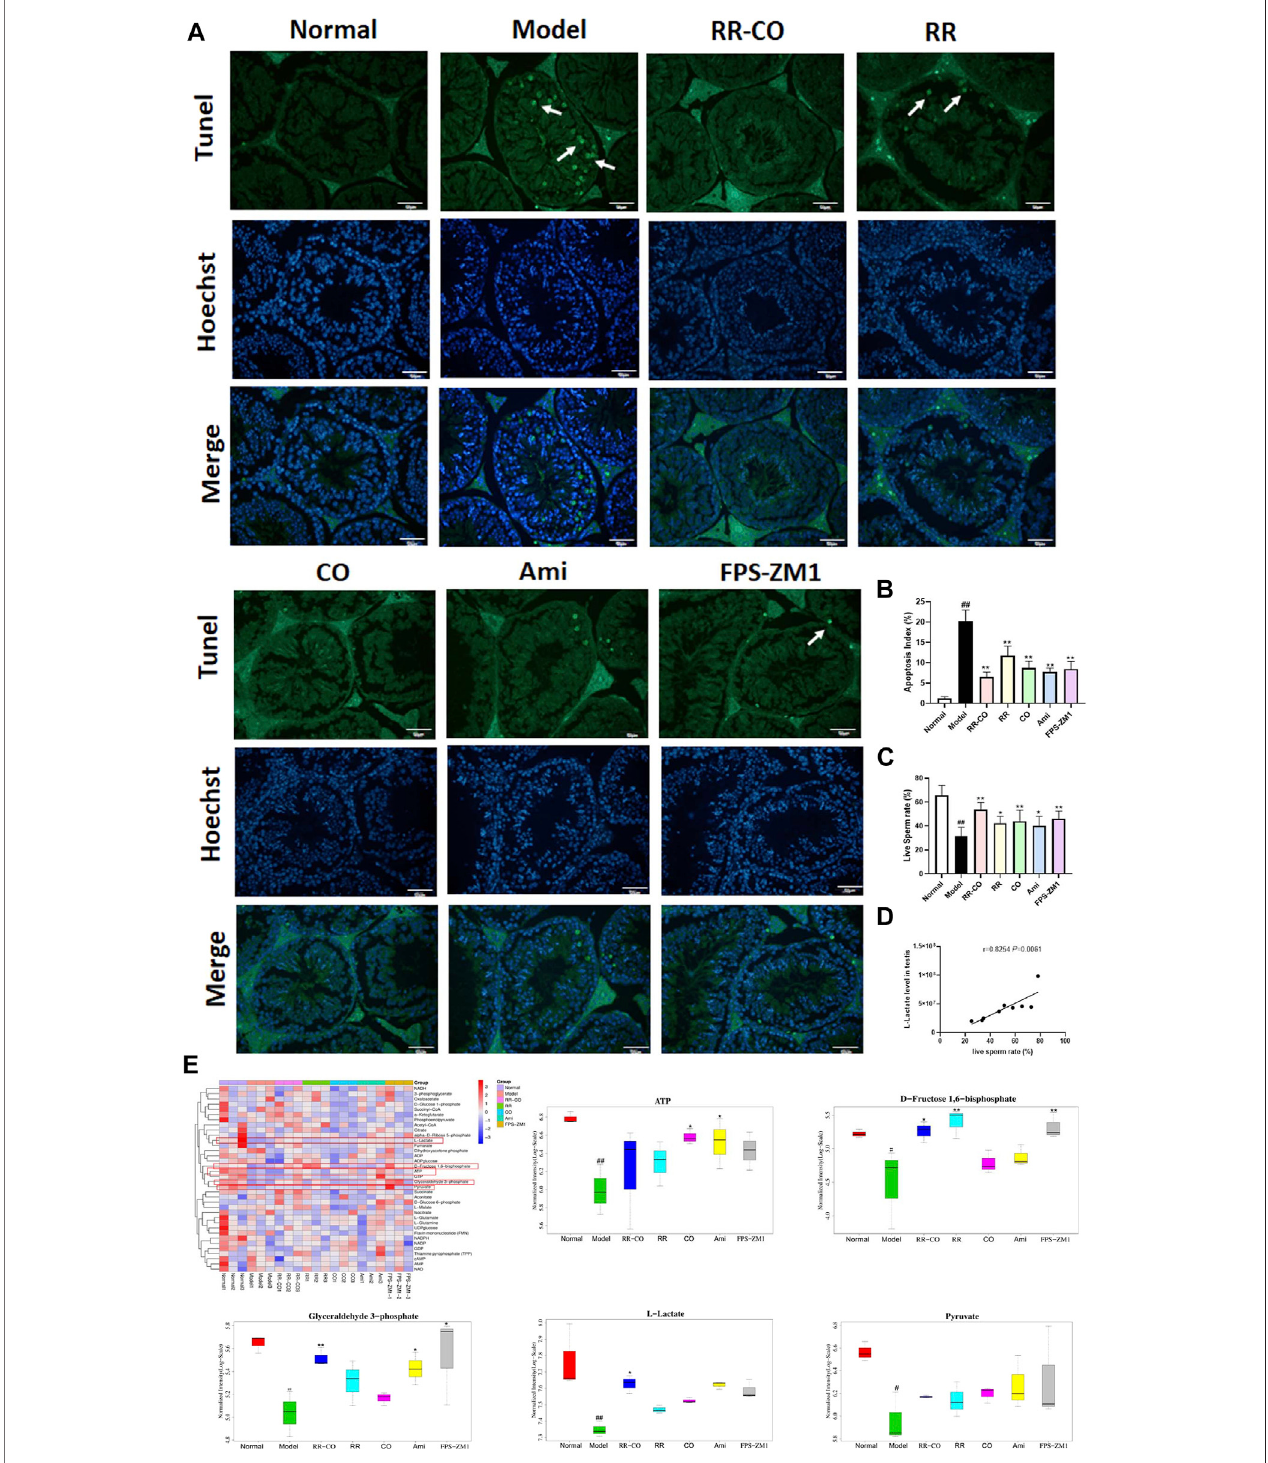
FIGURE3| EffectsofRR-COonthetestisapoptosis,glycolysismetabolites,andspermmotility (A) TUNELassaywasusedtodetecttesticularapoptosis,ofwhich apoptoticcellswereindicatedusingwhitearrows,and thecellnucleiweresubjectedtoHoechststaining(200 × magni fi cation) (B) ApoptosisindexforTUNELassays (C) Live Sperm rate (D) Correlation analysis between L -lactate level and Live Sperm rate (E) Heat map of glycolysis metabolites measured using LC-MS/MS and statistical diagram of differential glycolysis metabolites. Signi fi cance: ## p < 0.01 vs. normal group; * p < 0.05, ** p < 0.01 vs. model group.